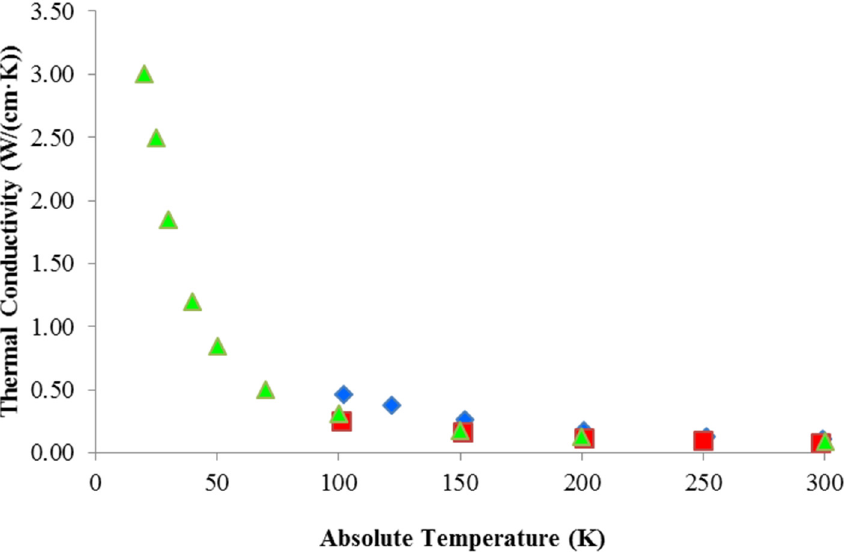
Figure 11. Thermal conductivity as a function of absolute temperature of the undoped anaxial laser materials LuAG (green) [45], YAG (blue) [3,29] and LuAG (red) [29].